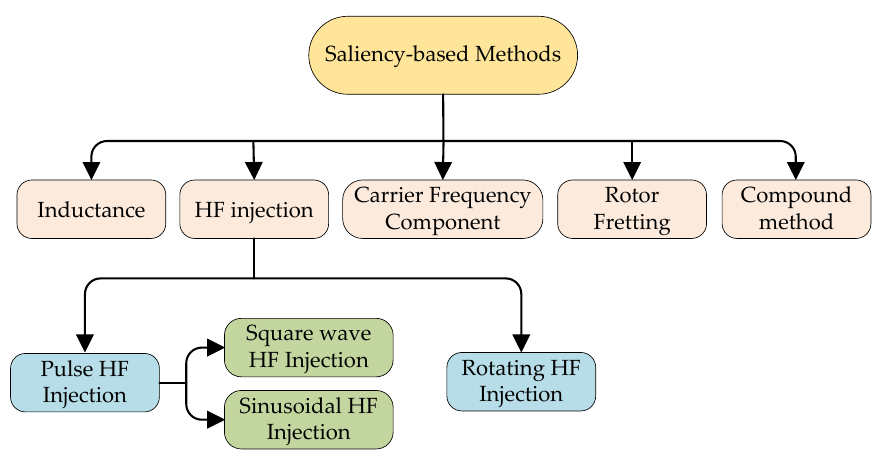
Figure 1. Sensorless strategies for initial and low speed.